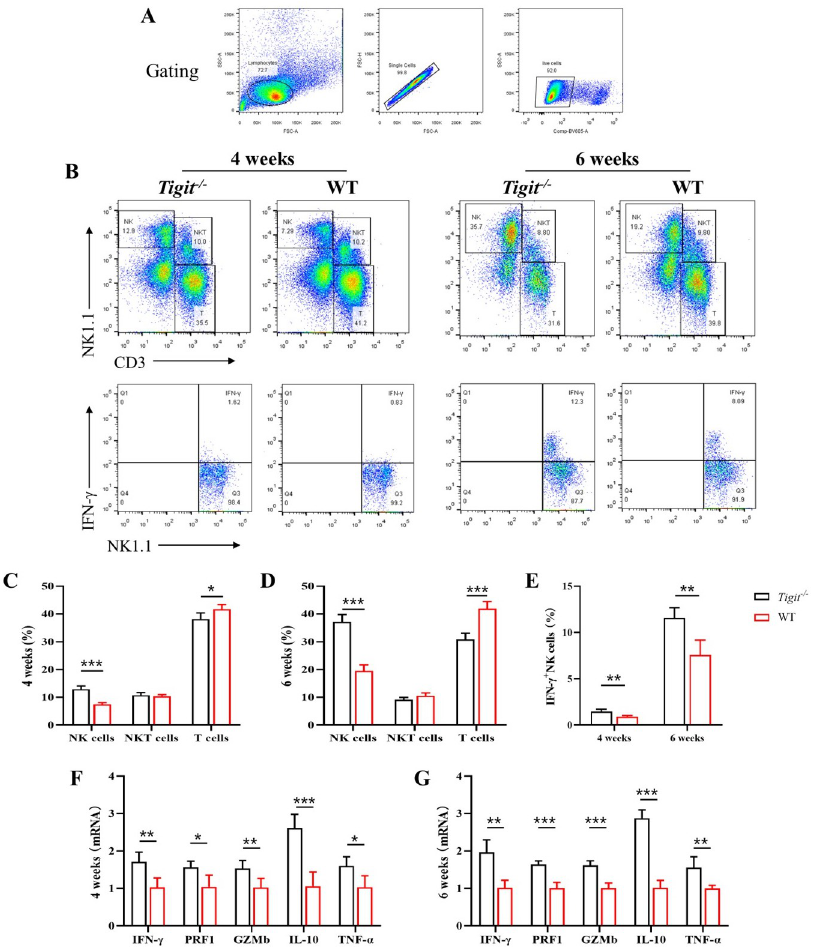
Fig 4. Tigit knockout enhanced natural killer (NK) cell proportion and activity. (A) Gating strategies for lymphocytes, single cells, and viable cells in hepatic non-parenchymal cells. (B) Flow cytometry scatter plots indicating the proportions of NK cells, natural killer T (NKT) cells, T cells, and IFN- γ + NK cells at 4 and 6 weeks post infection in Tigit -/- and WT mice. (C-D) Histogram of the proportions of hepatic NK, NKT, and T cells in Tigit -/- and WT mice at 4 and 6 weeks post infection. (E) Histogram of the IFN- γ + NK cell population in Tigit -/- and WT mice at 4 and 6 weeks post infection. (F- G) Relative mRNA transcript levels of Ifn- γ , Prf1 , Gzmb , Il-10 , and Tnf- α in hepatic NK cells derived from Tigit -/- and WT mice at 4 and 6 weeks post infection. � P < 0.05, �� P < 0.01, ��� P < 0.001.